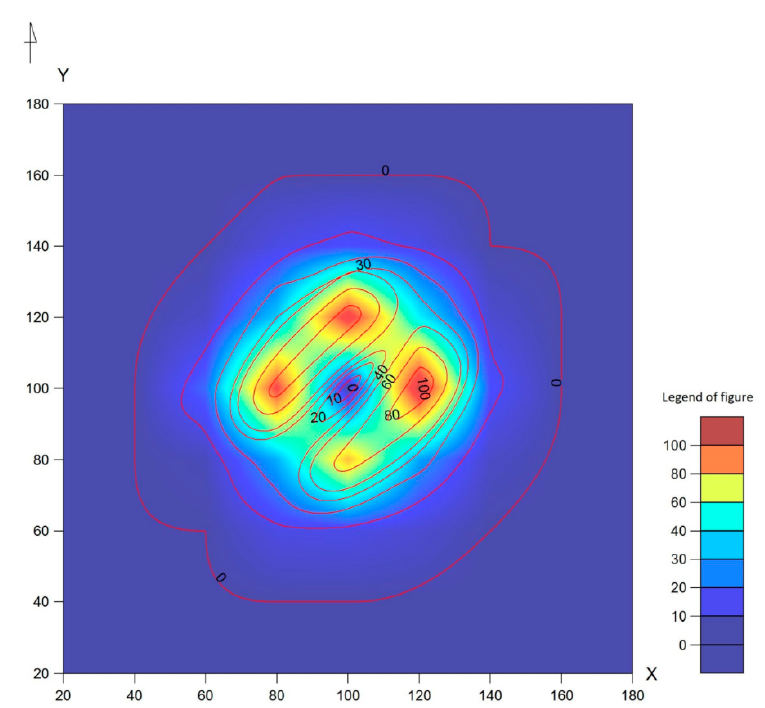
Figure 4. Frequency of exceedances in the network of sensors at a height of 10 m.